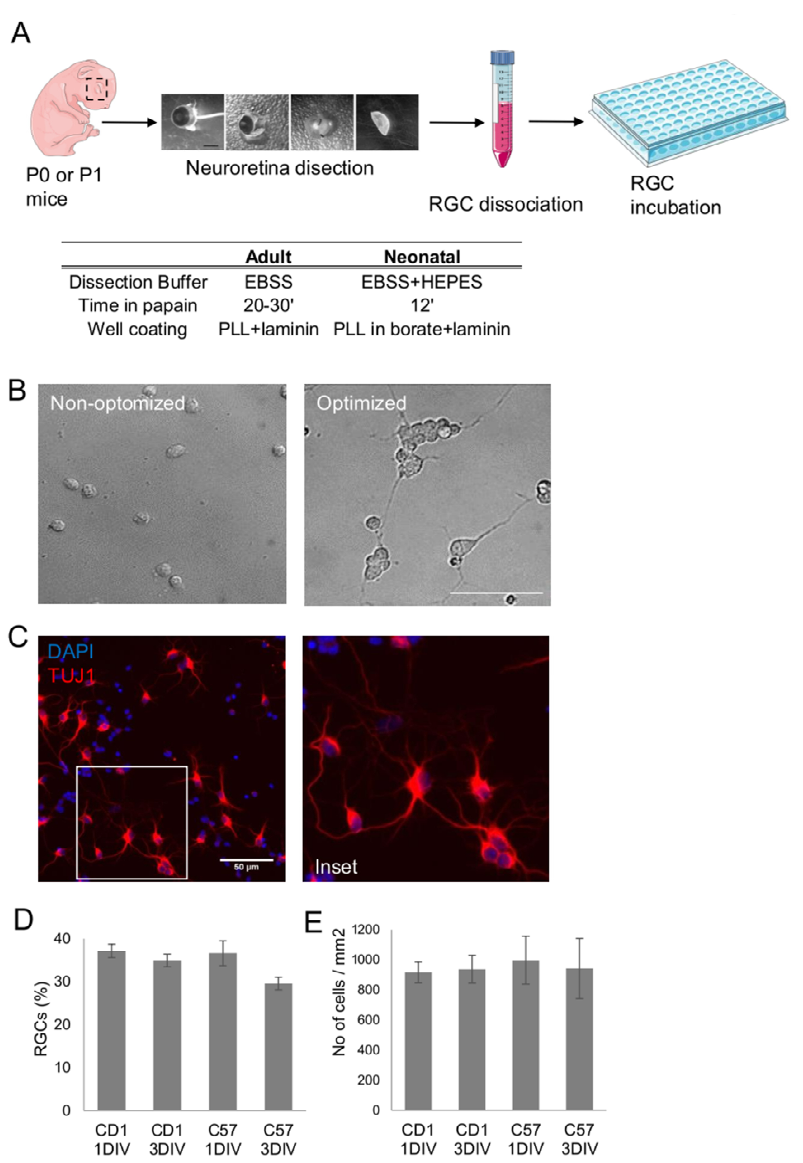
Figure 1. RGC culture optimization. ( A ) Experimental design and optimization steps for the improved isolation and culture. ( B ) Representative bright field images of the RGCs before and after the optimization protocol, scale bar 25 µ m. ( C ) Representative β -III tubulin staining in red of RGCs 3 DIV, nuclei stained with DAPI is shown in blue, scale bar 50 µ m. ( D , E ) % of RGCs and number of cells / mm 2 in the primary cultures isolated from CD1 and C57 mouse strains.